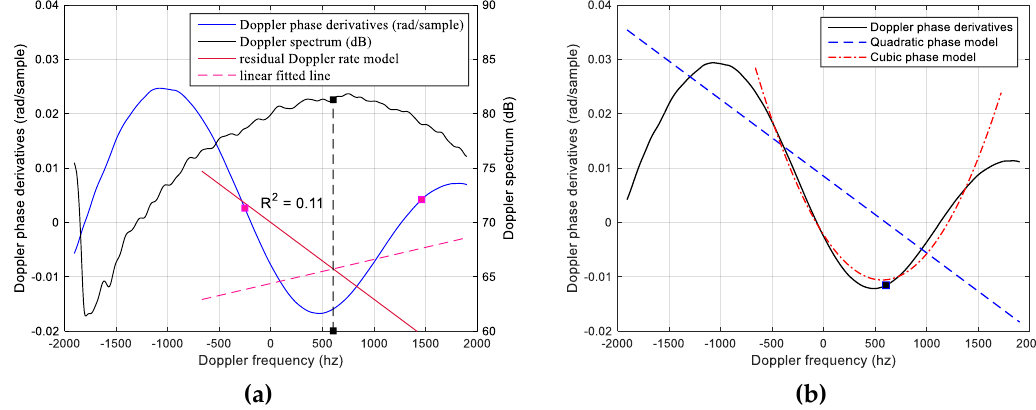
Figure 7. Analysis of acceleration and cubic-phase motion for vehicle 3 in Figure 2. ( a ) Doppler spectrum (black solid line), residual Doppler rate model (red solid line), and Doppler phase derivatives (blue solid line). ( b ) Estimation of cubic phase. There was a very low correlation of 0.11 between the residual Doppler rate model and the Doppler phase derivatives, as in ( a ), and consequently, it was not possible to estimate an across-track acceleration component. On the contrary, the shape of the Doppler phase derivatives indicates a cubic-phase motion. The best-fitted cubic-phase model in ( b ) was used for residual compression of the target signals.